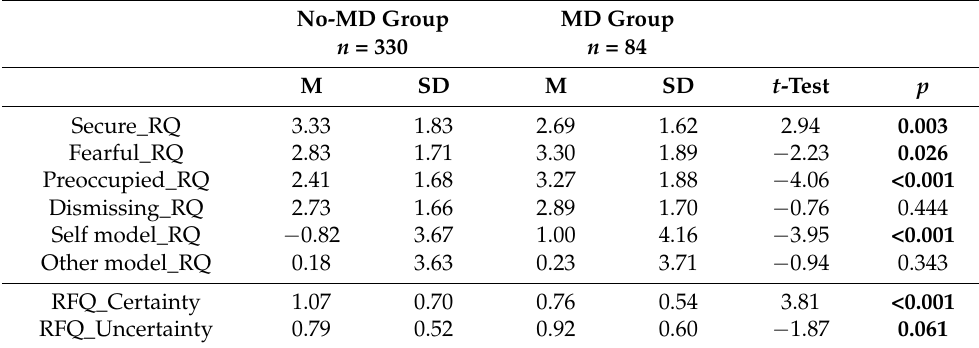
Table 1. Differences in attachment and reflective functioning between No-MD and MD